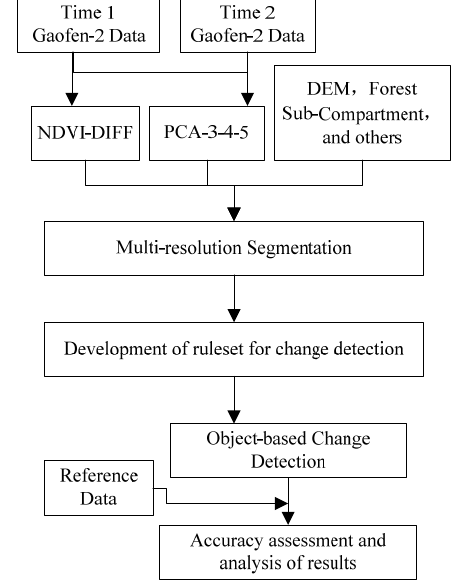
Fig.3 The procedure of object-based ruleset classification system for forest cover monitoring